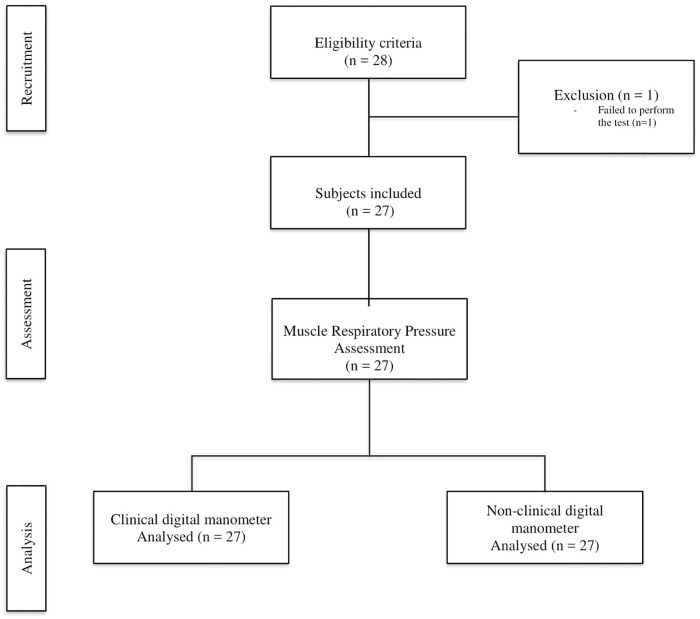
Study flowchart.